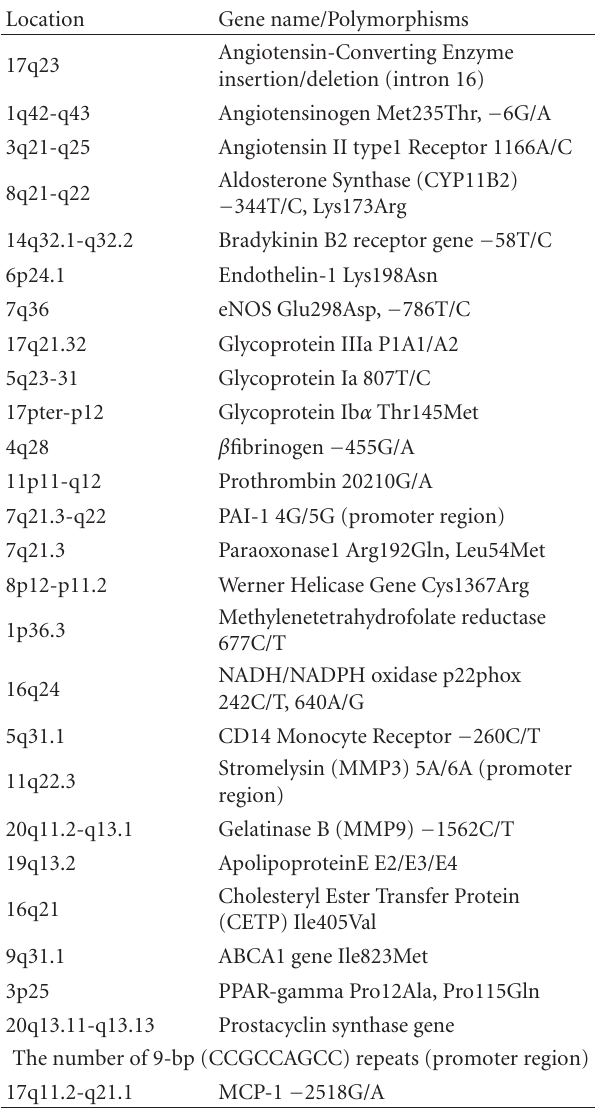
Table 1: The well-known genetic polymorphisms which are thought to be associated with myocardial infarction or coronary artery disease.